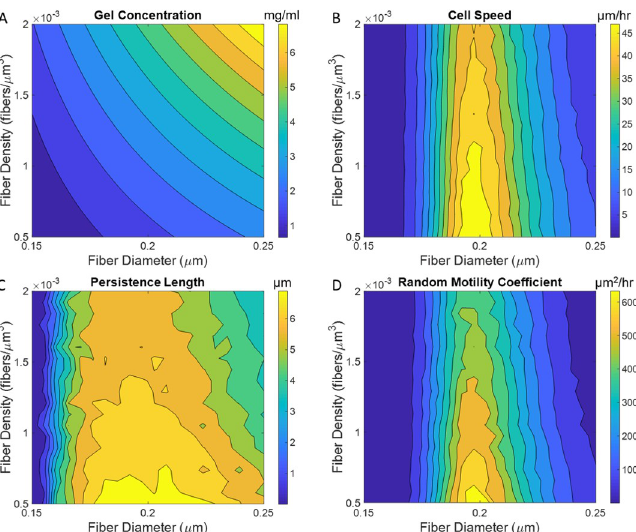
Fig 4. Effect of collagen concentration. Contour plots for gel concentration, v avg , L p , and μ as a function of increasing fiber diameter and density A) Gel concentration B) Cell speed C) Persistence length D) Random motility coefficient. ρ i = 6 sites/monomer, ρ fiber = 1.0 x 10 − 3 fibers/ μ m 3 , AI = 0, and t search = 16s. Simulation time = 48hrs. n = 20. 10 contour levels automatically chosen by MATLAB are